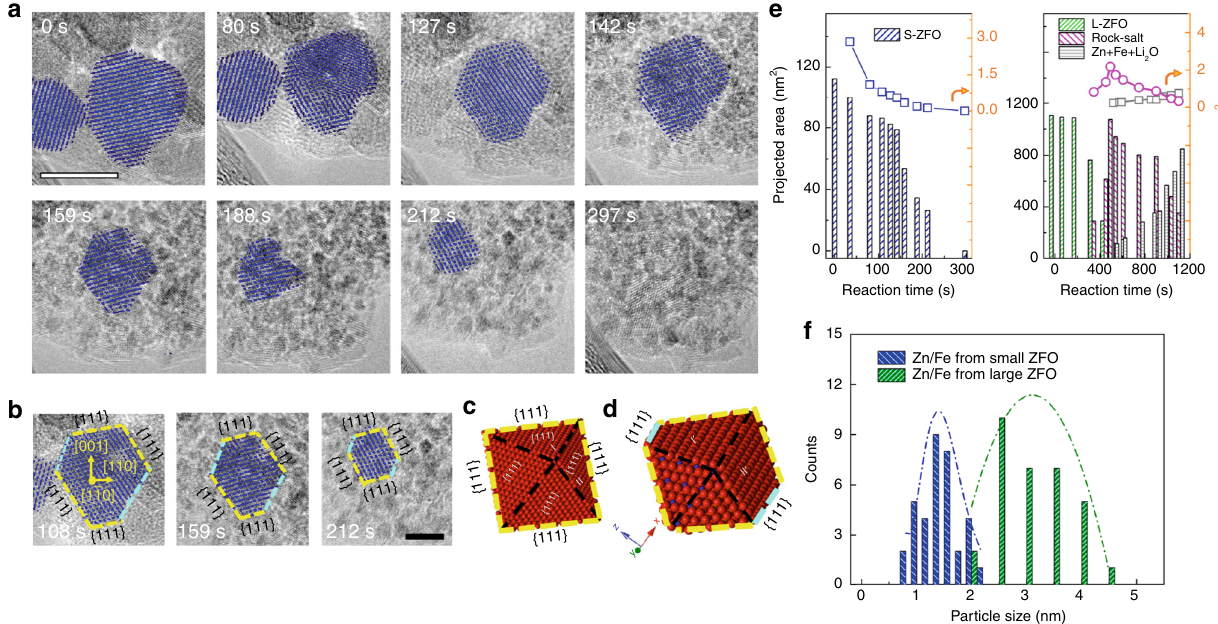
Fig. 4 In situ HRTEM study of S-ZFO and comparison of reaction kinetics of ZFO with different particle size. a Time-sequenced HRTEM images with phase information (overlaid false color) showing the phase evolution of S-ZFO as a function of reaction time. Scale bar: 10 nm. b Enlarged HRTEM images illustrating the preferred reaction interface. c Atomic model of {111} octahedron viewing along <110>direction. Scale bar: 5 nm. d Atomic model showing the structure of partially reacted {111} octahedron. e Projected area of spinel phase in S-ZFO (left panel, blue) and the three phases occurring in L-ZFO (right panel, green: L-ZFO, magenta: ordered rock-salt and gray: nanocomposite) changes as a function of time. Curves on the top of each panel showing the propagation speed of each reaction, which is the derivative of the projected area of each phase to reaction time (vertical axis on the right). f Size distribution of fi nal discharge products (Zn 0 /Fe 0 ) generated from S-ZFO (blue) and L-ZFO (green), 108 s from the <111> zone axis. It is interesting to note that by 108 s the exposed facets are {111} planes and these facets were maintained until the particle was fully lithiated (297 s), as indi- cated by the yellow and turquoise dashed lines in Fig. 4b. The